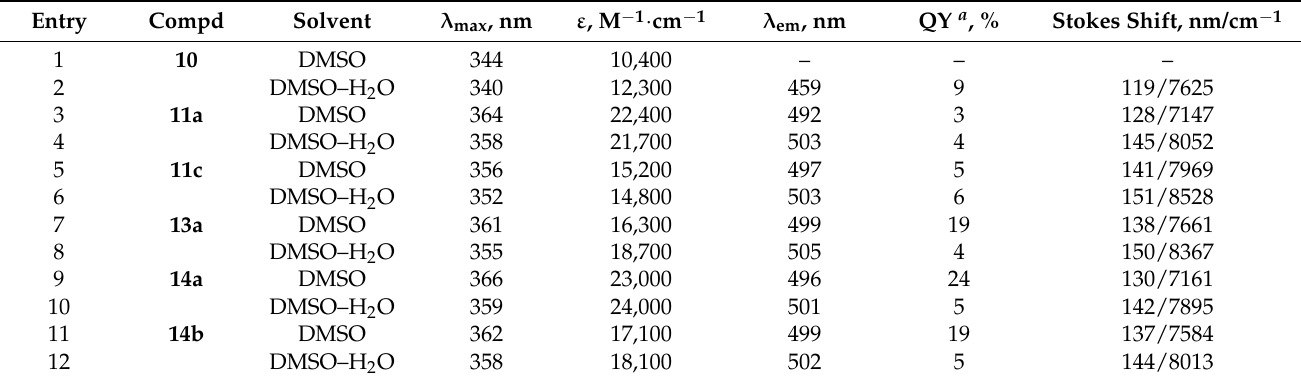
Table 4. Photophysical characteristics of DATs 10 , 11a , c , 13a , and 14a , b solutions in DMSO and